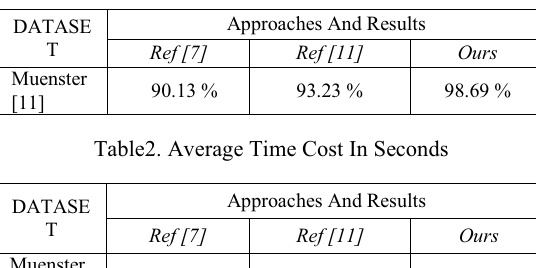
Table1. Comparison of Recognition Occupancy DATASE T